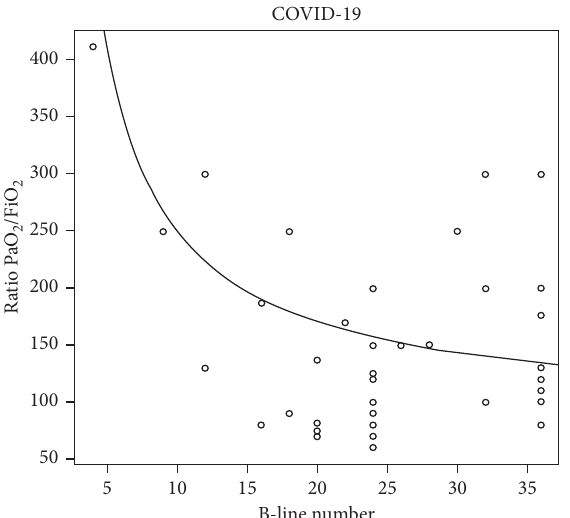
Figure 4: Demonstrates for COVID-19 patients, an inverse relationship between aeration score (B-line number) and the ratio PaO